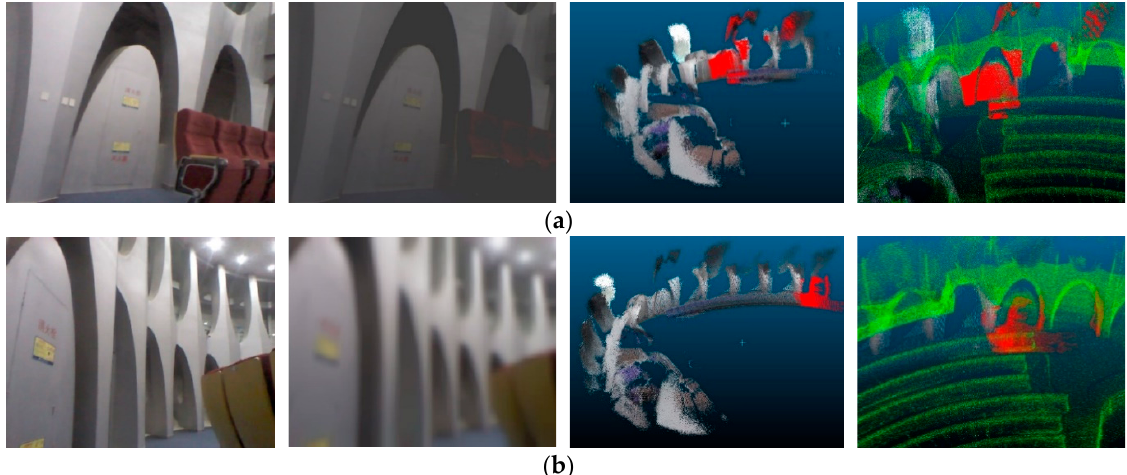
Figure 19. ( a ) Constructed points (red) overlap with the LiDAR data (green) after motion recovery in